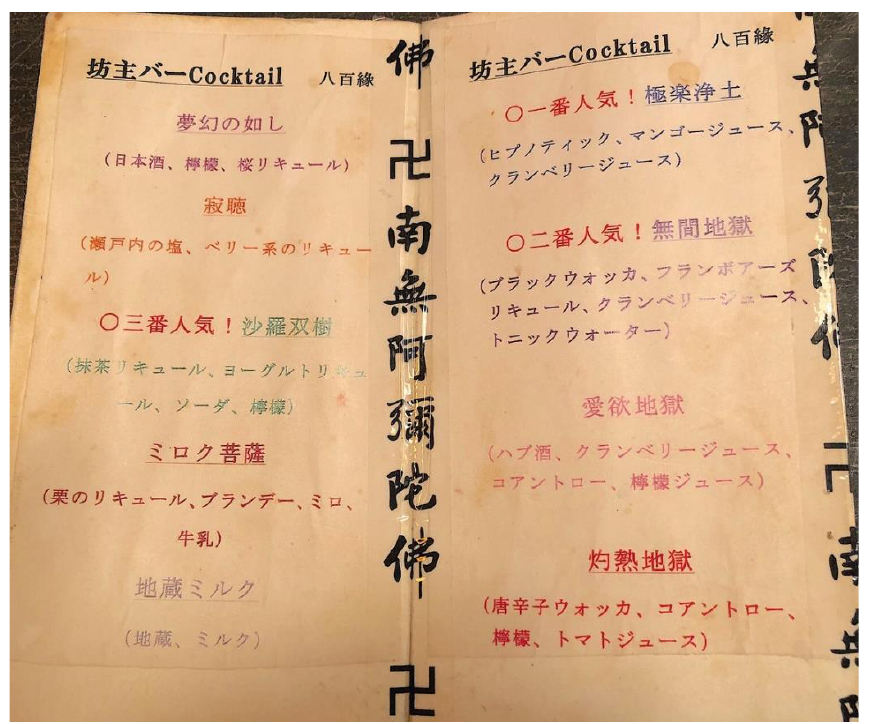
Figure 3. The drink menu from the Shinjuku Bōzu Bar. The inscribed centerfold says namu Amida Butsu (hail to Amida Buddha) and carries the symbol for temples in China, Korea, and Japan. 12 (Photo by the